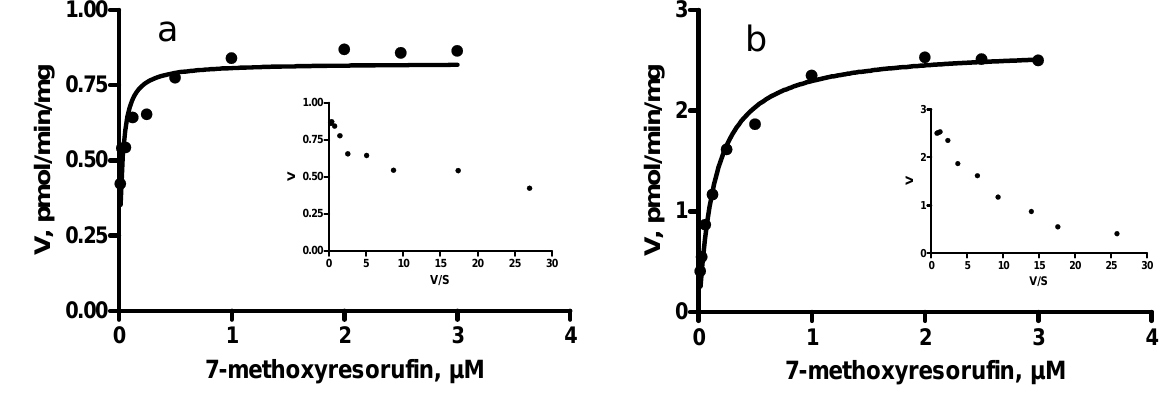
Figure 3. Saturation curve for 7-methoxyresorufin O -demethylation by hepatic microsomes from entire (a) and castrated (b) male pigs. Insets: Eadie-Hofstee transformations of the same data. V – velocity of resorufin formation; S -